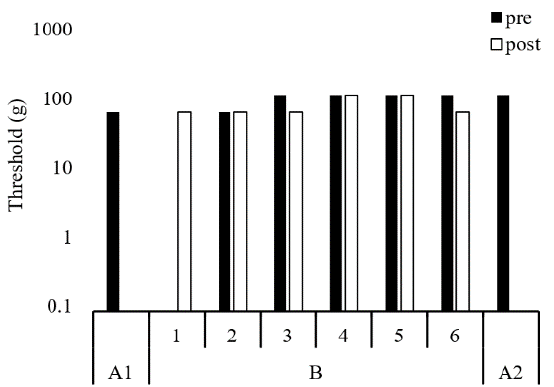
Figure 7. Tactile pressure sensitivity threshold in the right first metatarsal head. The vertical axis is logarithmic.